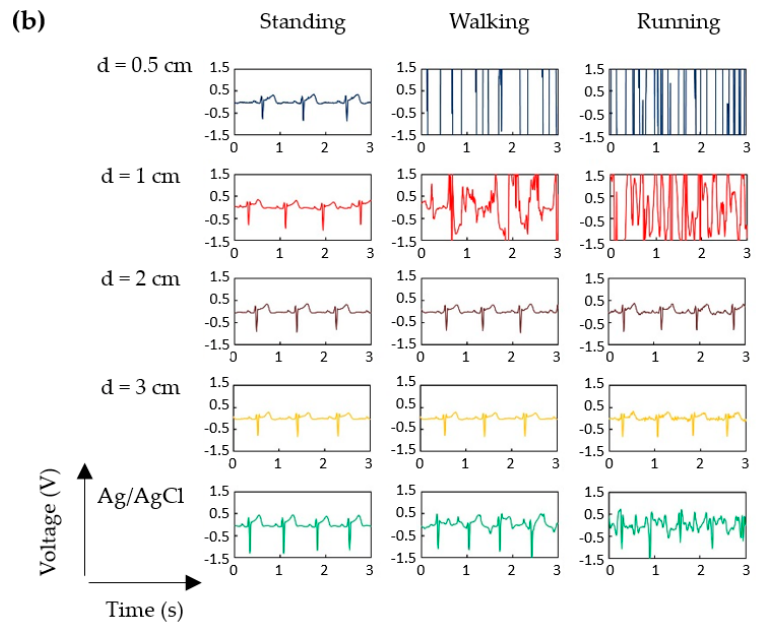
Figure 10. ( a ) Contact impedance and ( b ) ECG signals measured for P-electrodes of different